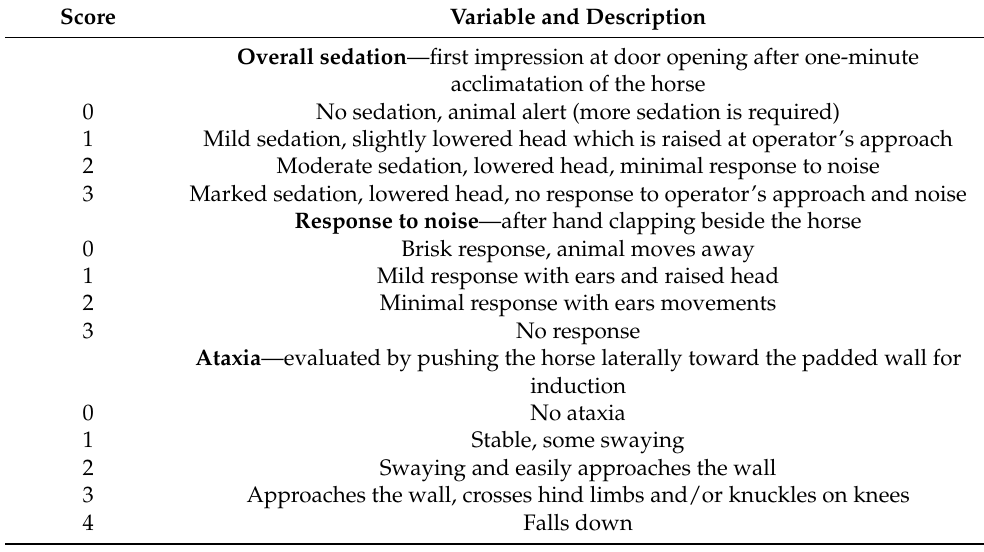
Table 1. Simple descriptive scale (SDS) scoring system for the overall sedation, ataxia, postural instability, response to noise.